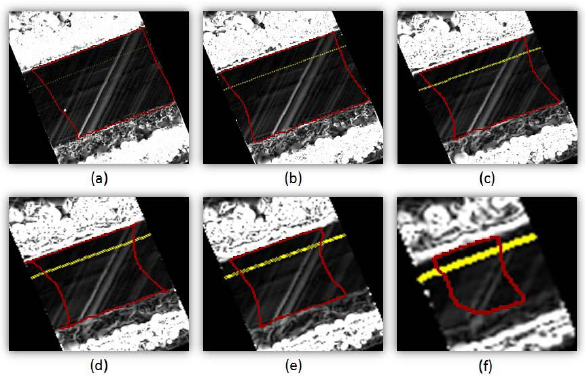
Figure 4: Final position of the snake curve over the slope raster surface with (a) 0.02 m 2 , (b) 0.04 m 2 , (c) 0.06 m 2 , (d) 0.08 m 2 , (e) 0.1m 2 and (f) 0.2m 2 cell